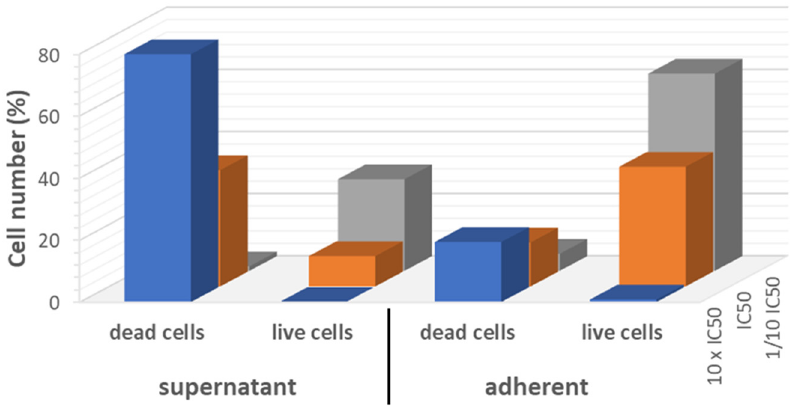
Figure 6. Percentage of live and dead A2780 cells in the supernatant or adherent after 48 h of exposure to the IC 50 of JHOR11, or to a concentration 10 times higher than the IC 50 of JHOR11 (10 × IC 50 ), or to a concentration 10 times lower than the IC 50 of JHOR11 (1/10 IC 50 ).